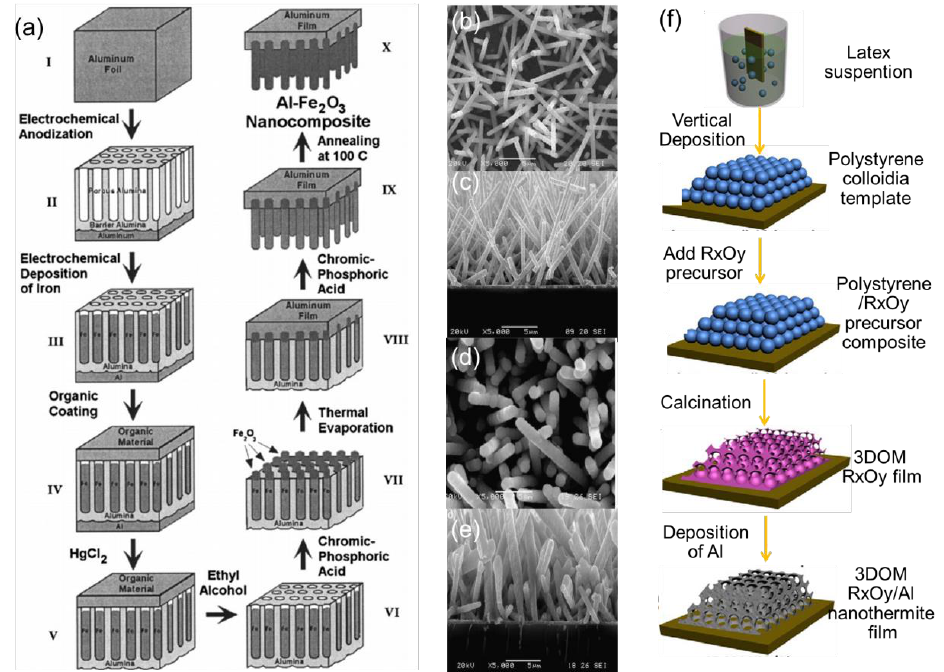
Figure 7. ( a ) The steps for preparing Al/Fe 2 O 3 energetic nanocomposites [94] Copyright 2012, Journal of Applied Physics, SEM images (( b ) top view and ( c ) cross-section view) of the Co 3 O 4 na- norods; SEM images (( d ) top view and ( e ) cross-section view) of the Al/Co 3 O 4 nEMs [96]